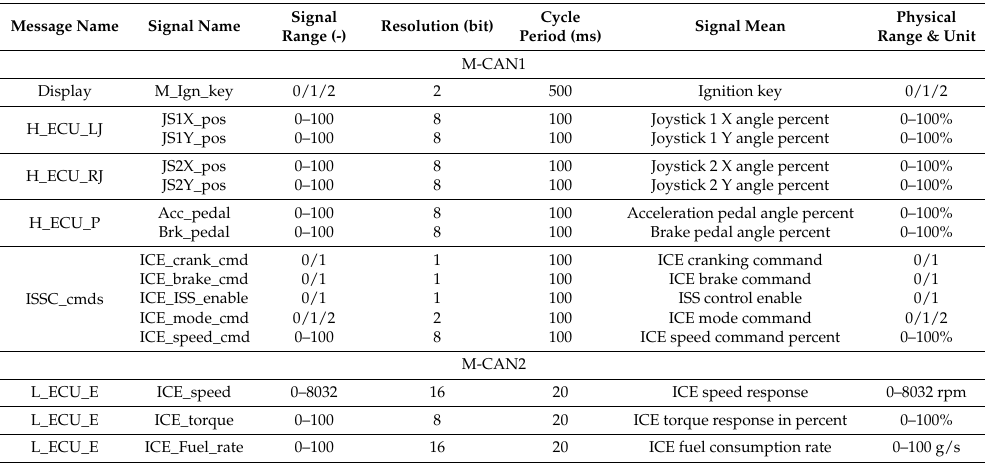
Table 2. CAN message-signal design for HIL